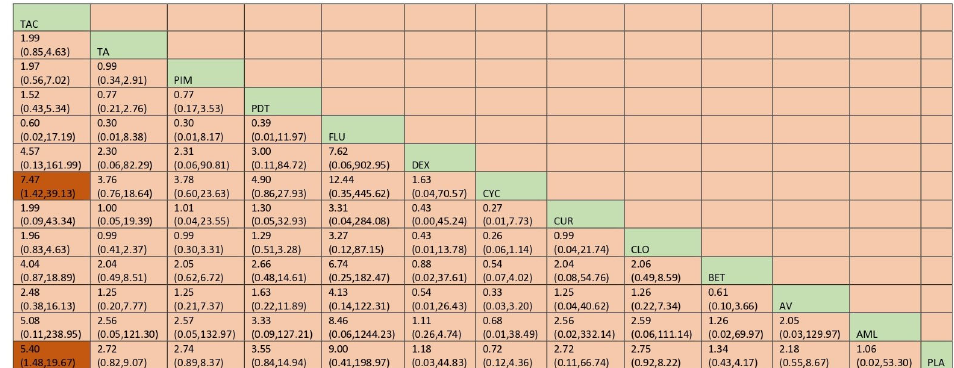
Figure 19. League table: Clinical Resolution (subgroup analysis). Abbreviations: AML, amlexanox paste; AV, aloe vera; CUR, curcumin gel; PDT, photodynamic therapy; PLA, placebo; PUR, purslane; TAC, tacrolimus; FLU, flucinonide acetonide; CLO, clobetasol propionate; PIM, pimecrolimus; BET, betamethasone; TA, triamcinolone acetonide; DEX, dexamethasone; CYC, cyclosporine. The green highlights indicate the interventions and the dark highlights indicate the significant results.